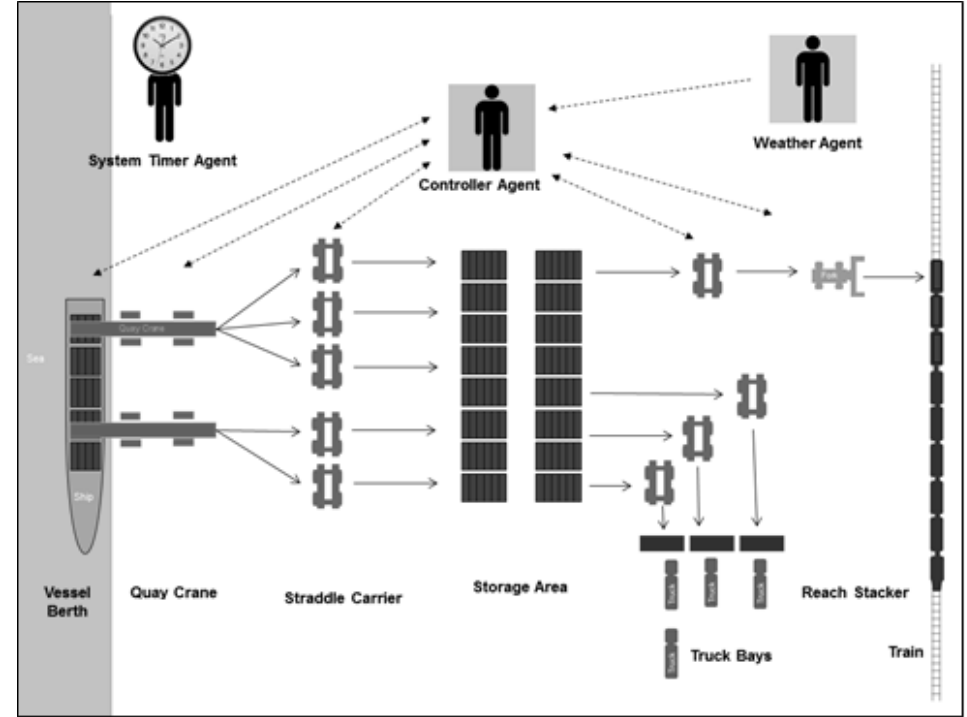
Figure 3. System agents and their interactions Table 1. Operational agents